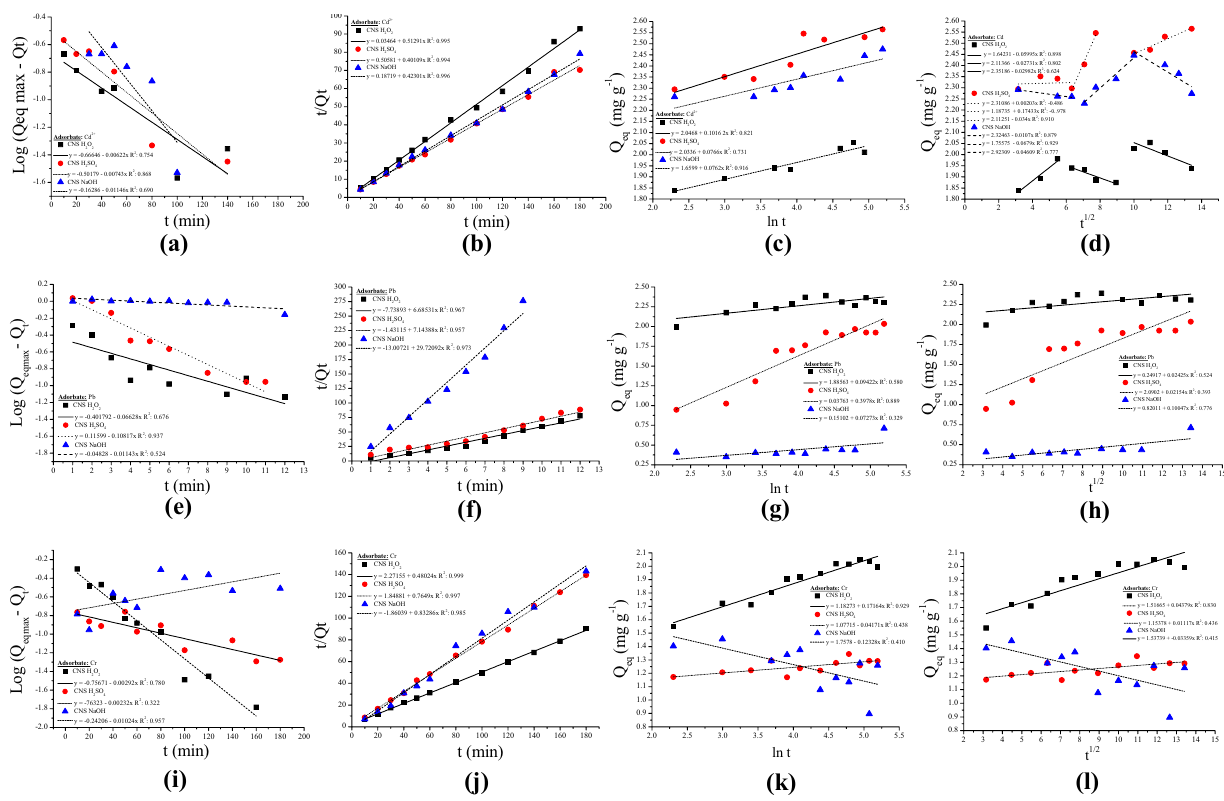
Fig. 9 Kinetic models of pseudo-first order ( a , e , i ), pseudo-second order ( b , f , j ), Elovich ( c , g , k ) and intraparticle diffusion ( d , h , l ) for sorp- tion of Cd 2+ , Pb 2+ and Cr 3+ , respectively, by CNS modified with H 2 O 2 , H 2 SO 4 and